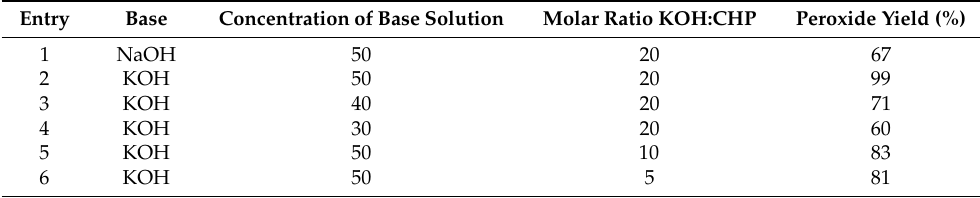
Table 3. The e ff ect of end groups and chain length of polyethylene glycols. Reaction conditions: